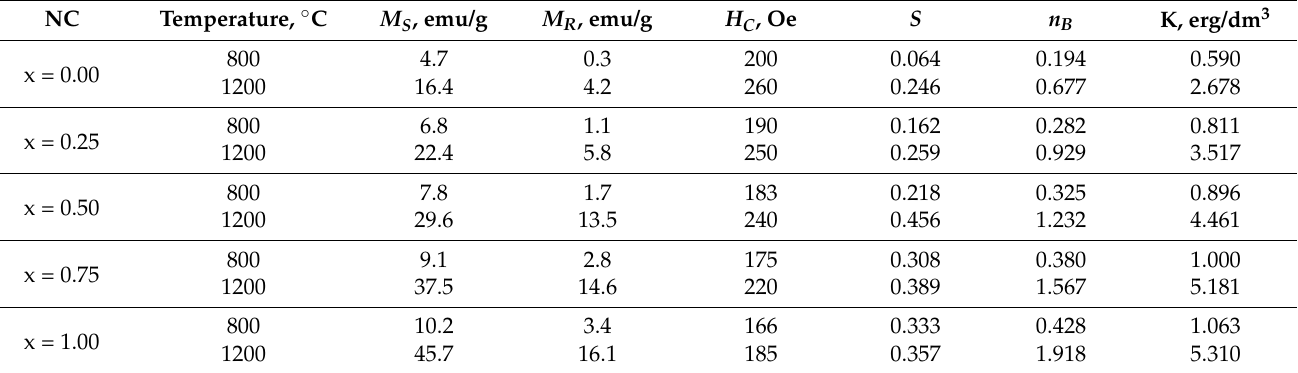
Table 3. Saturation magnetization ( M S ), remanent magnetization ( M R ), coercivity ( H C ), squareness ( S